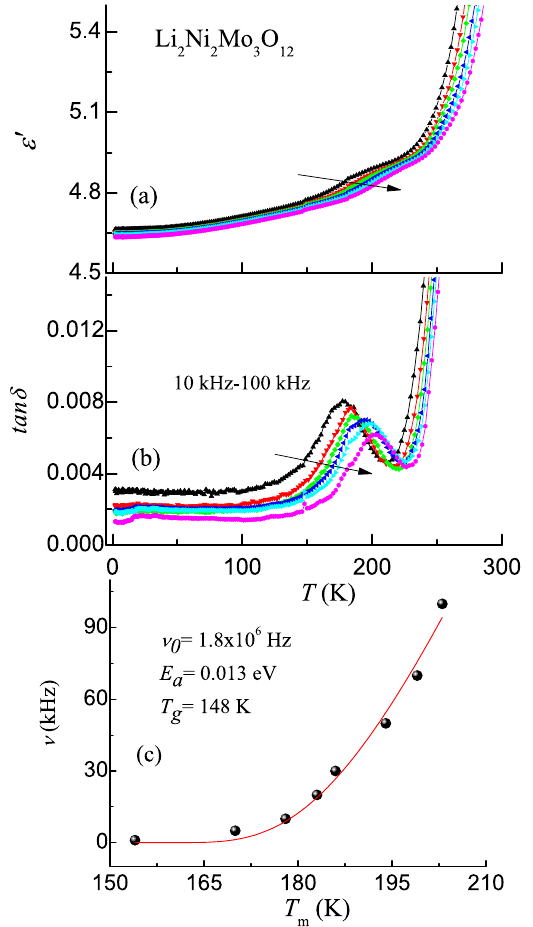
Figure 2. (a) Real part of the permittivity and (b) loss as a function of temperature with varying frequency for Li 2 Ni 2 Mo 3 O 12 . Arrows are drawn to show that the curves shift to higher temperature range as the frequency is increased (shown for 10, 20, 30, 50, 70 and 100 kHz). In ( c ), Vogel-Fulcher fitting for the tan δ peak values is